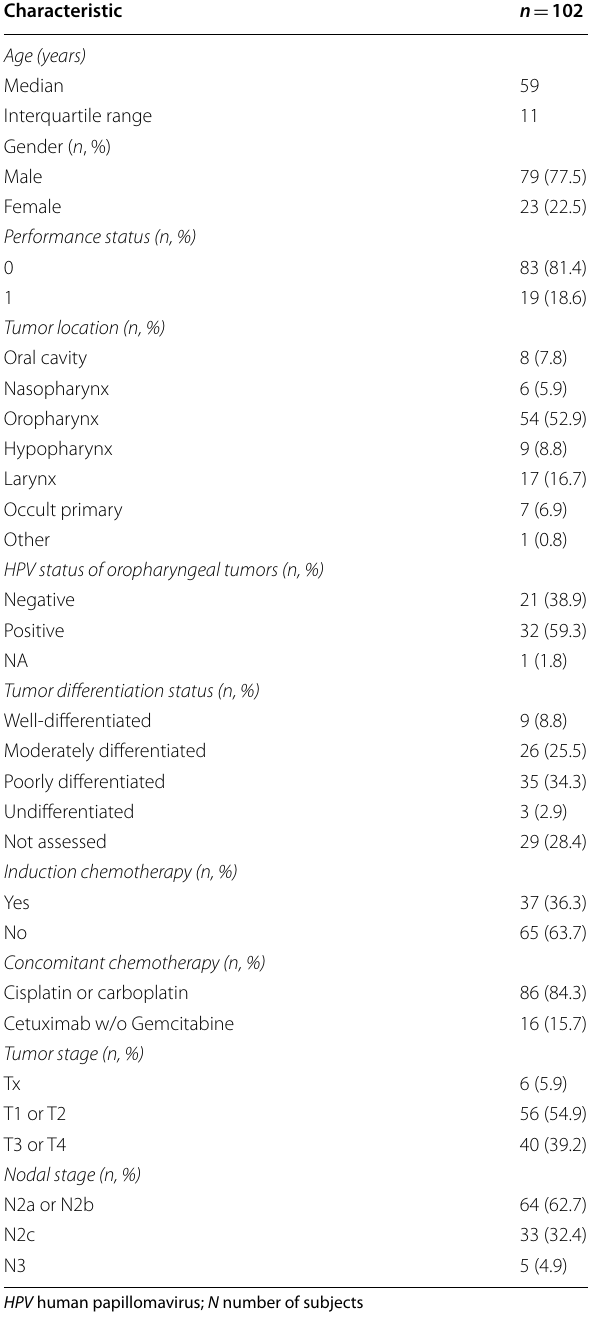
Table 1 Patient and tumor